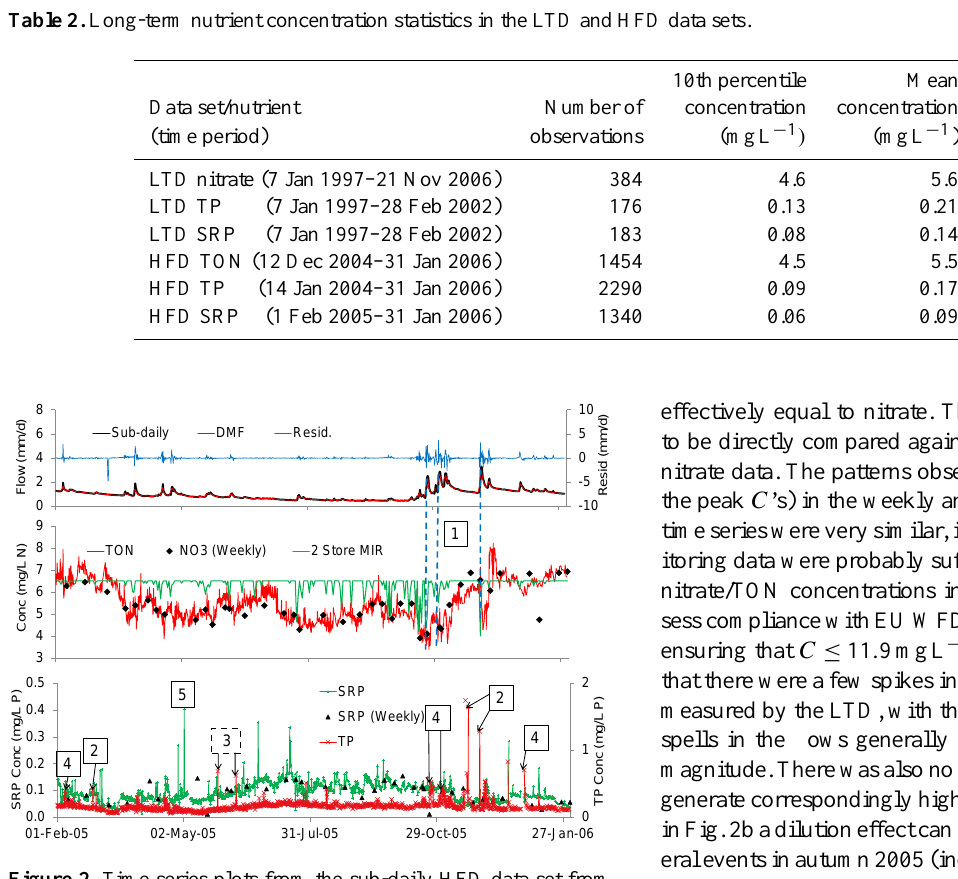
Figure 2. Time series plots from the sub-daily HFD data set from the Frome at East Stoke monitoring point showing (a) flow data from the catchment outlet comparing the daily mean (DMF) with sub-daily flows by showing the residual, (b) TON and (LTD) nitrate data, the results of a two-store MIR model of nitrate (green line), (c) (HFD) TP and (HFD and LTD) SRP